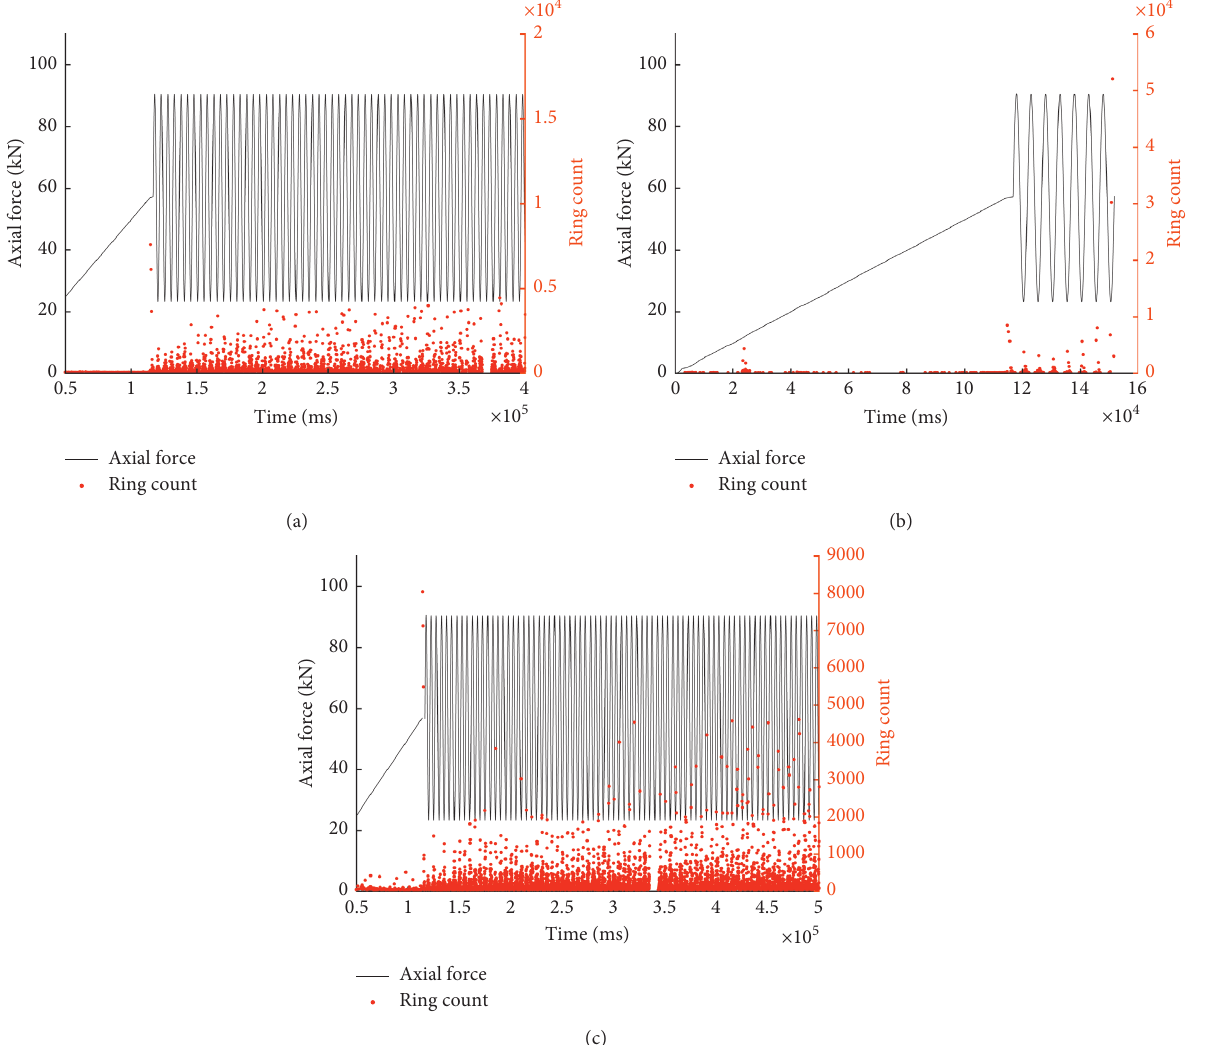
Figure 6: Acoustic emission evolution law of sandstone under different saturation conditions. (a) Evolution of acoustic emission in natural state. (b) Evolution of acoustic emission in saturated state. (c) Evolution of acoustic emission in dry